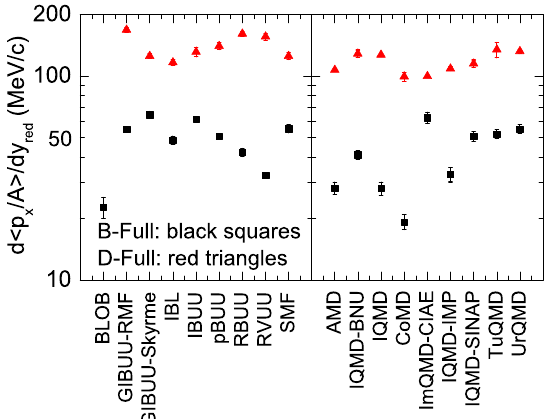
Figure 2. (Color on-line) Comparison of flow parameters (transverse momentum at midrapidity) in Au+Au collisions at 100 AMeV (square (black) symbols) and 400 AMeV (triangular (red) symbols) for codes of Boltzmann–Uehling–Uhlenbeck (BUU) type (left) and quantum molecular dynamics (QMD) type (right). For the identification of the different codes, see [27], from where this figure is